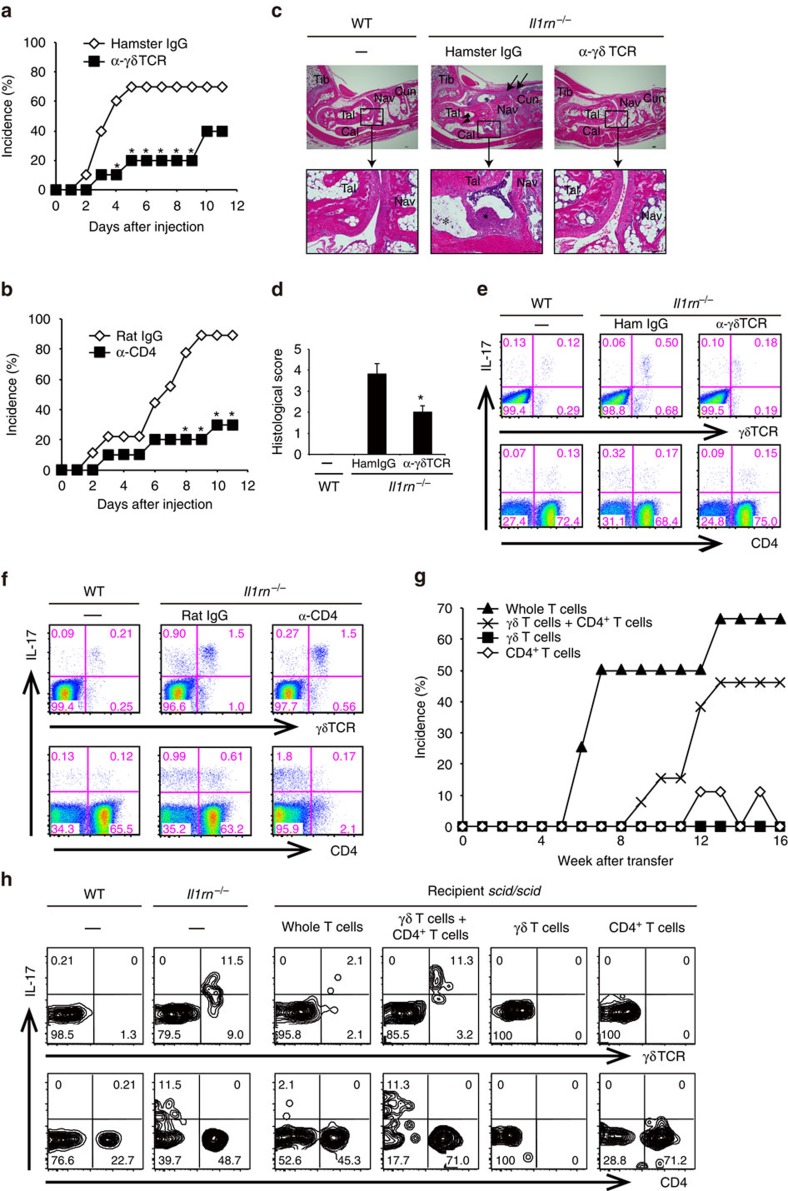
Collaboration between CD4+ T cells and γδ17 cells is important for the development of arthritis.(a,b) Suppression of arthritis development in Il1rn−/− mice after treatment with anti-γδ TCR (a) or anti-CD4 (b) mAb. Non-arthritic Il1rn−/− mice at the age of 4 weeks were injected on days 0, 3, 7 and 10 (ages of 28, 31, 35 and 38 days) with anti-γδ TCR mAb (▪, n=10) or isotype-matched hamster IgG (◇, n=10) (a), or with anti-CD4 mAb (▪, n=10) or isotype-matched rat IgG (◇, n=9) (b). *P<0.05 versus control IgG, assessed by the χ2-test. (c,d) Non-arthritic Il1rn−/− mice at the age of 20 days were injected with anti-γδ TCR mAb or hamster IgG every 3 days (ages of 20, 23 and 26 days), and mice were killed at the age of 27 days. Representative haematoxylin and eosin-stained sections of ankle joints in non-treated WT mouse (left column, n=6) and Il1rn−/− mouse treated with control hamster IgG (middle column, n=6) or α-γδ TCR mAb (right column, n=5) are shown. Synovial cell proliferation and inflammatory cell infiltration (arrows), bone erosion (arrowheads), fibrin clots (*) and pannus formation (★) in control Il1rn−/− mouse (middle column) are indicated. Scale bars, 100 μm. Tib, tibia; Tal, talus; Cal, calcaneum; Nav, navicular bone; Cun, cuneiform bone (c). (d) The means of histological scores are shown. *P<0.05 versus Il1rn−/− mice treated with hamster IgG. (e,f) Flow cytometry of LN cells from antibody-treated Il1rn−/− mice. Cells were collected from Il1rn−/− mice, 8 days after the first injection with anti-γδ TCR mAb or hamster IgG-treated (e) or 11 days after the first treatment with anti-CD4 mAb or rat IgG (f) or from non-treated WT mice. Cells were stimulated with P/I for 5 h, and then stained for intracellular IL-17. Numbers refer to percentages in CD3ɛ+ cells. (a–f) Data are representative of two independent experiments. (g,h) scid/scid mice at the age of 4 weeks were transferred with γδ T cells from Cd4−/−Il1rn−/− mice (▪, n=8), CD4+ T cells from Tcrd−/−Il1rn−/− mice (◇, n=9), Thy1.2+ T cells (whole-T cells) from Il1rn−/− mice (▪, n=8) or γδ T cells from Cd4−/−Il1rn−/− mice plus CD4+ T cells from Tcrd−/−Il1rn−/− mice (× , n=13). Incidence of arthritis is shown (g). Flow cytometry of the joint-infiltrating cells of scid/scid mice after 18 weeks of transfer, or age-matched and non-treated WT or Il1rn−/− mice (h). Cells were stimulated with P/I for 5 h, and then stained for intracellular IL-17. Numbers refer to percentage in CD3ɛ+ cells. Data are pooled from g or representative of (h) two independent experiments.